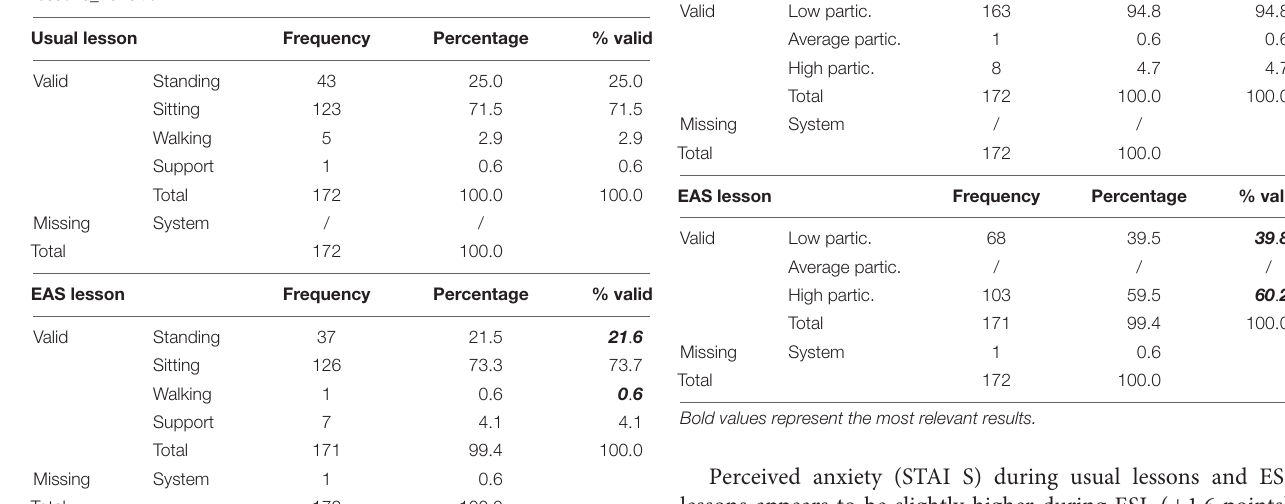
TABLE 8 | Proxemic differences between usual lessons and EAS lessons_transition.